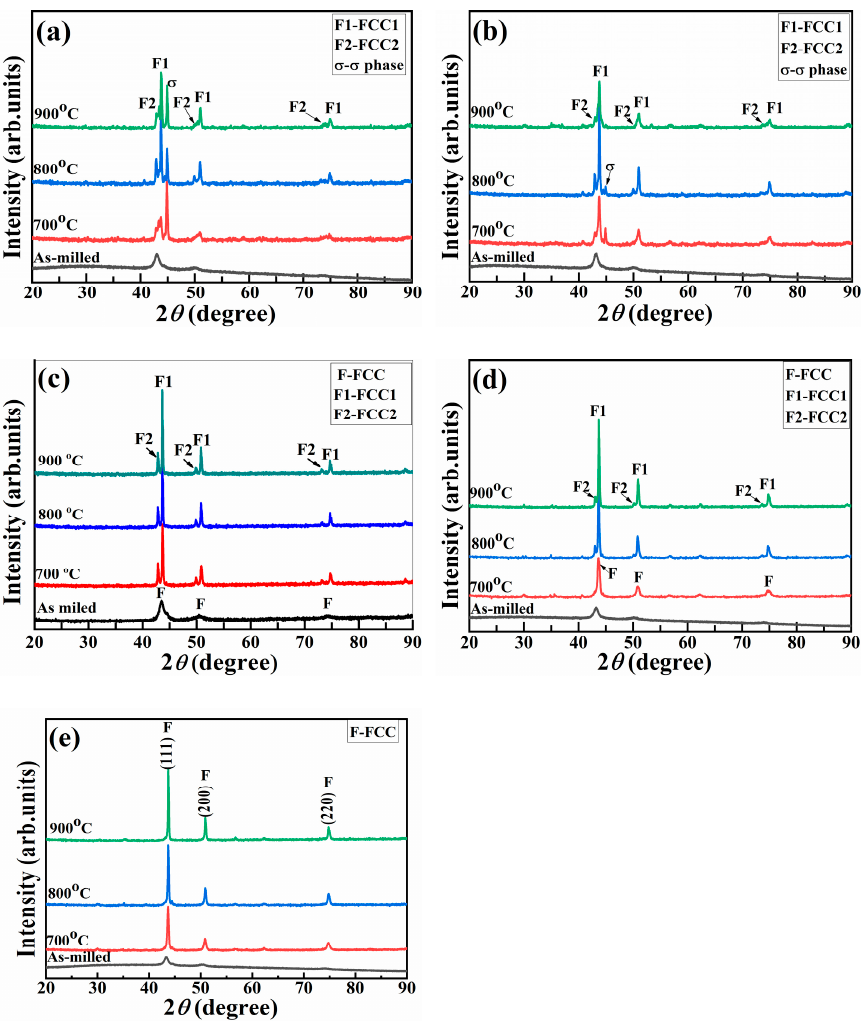
Figure 11. XRD results of CoCrCuFeMnNi x HEAPs after vacuum annealing at different temperatures: ( a ) Ni 0 , ( b ) Ni 0.5 , ( c ) Ni 1.0 , ( d ) Ni 1.5 , ( e ) Ni 2.0.